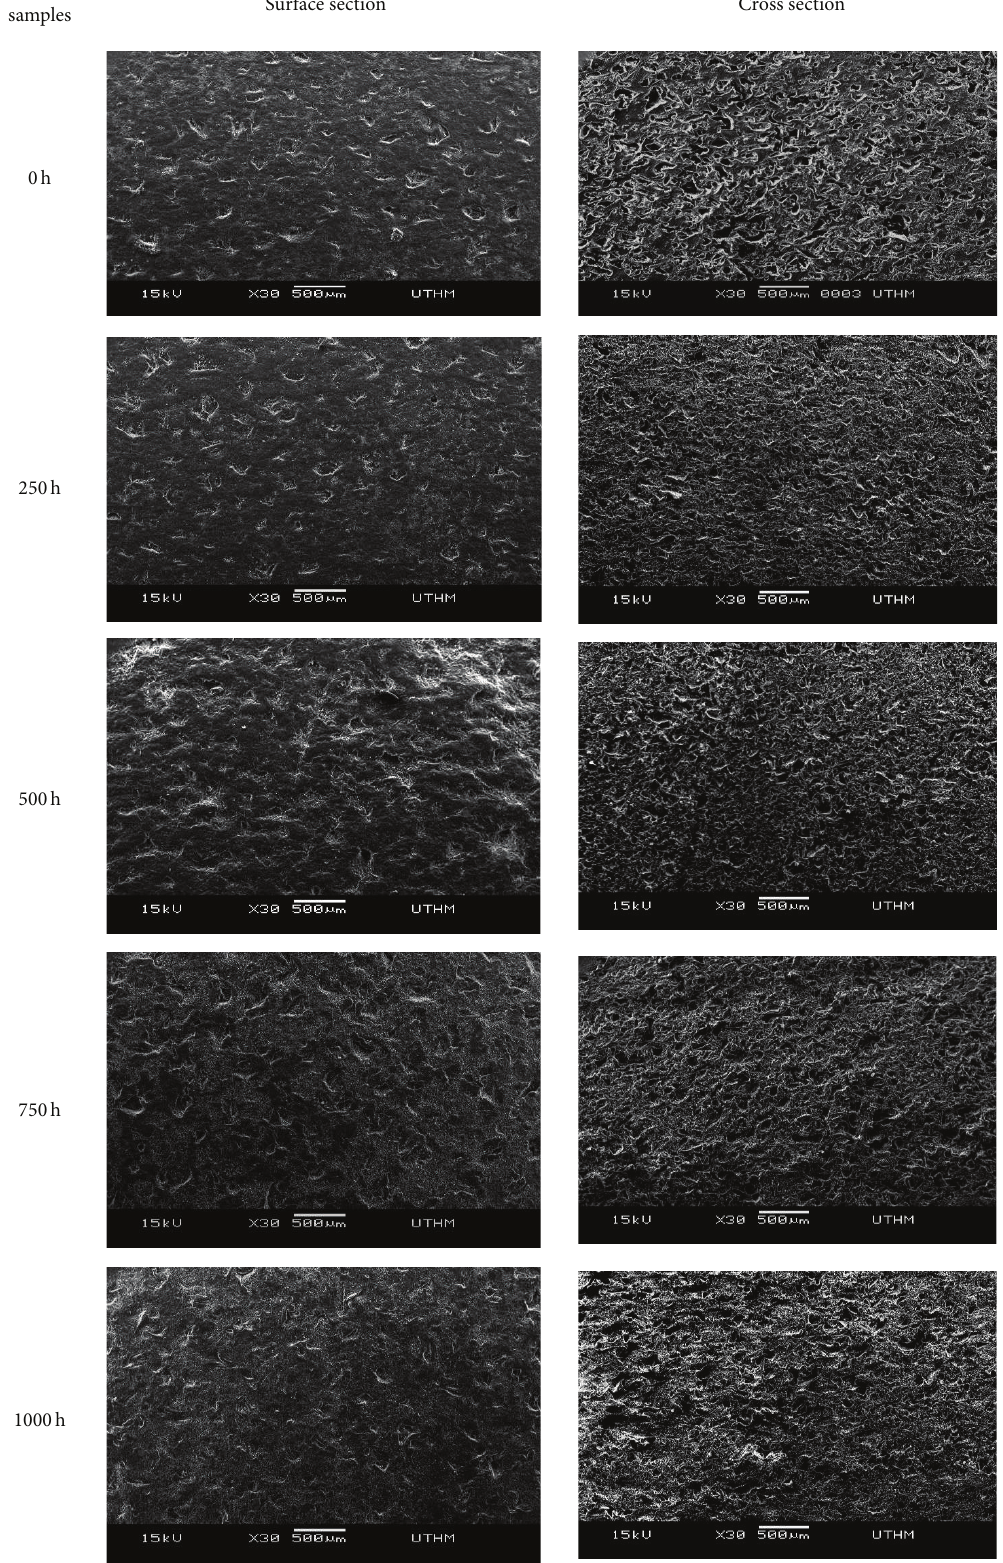
Figure 7: Morphology of CB samples with UV